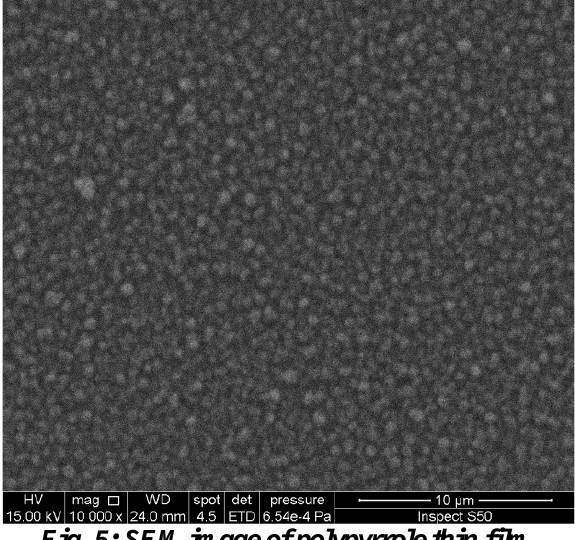
Fig. 5: SEM image of polypyrrole thin film.